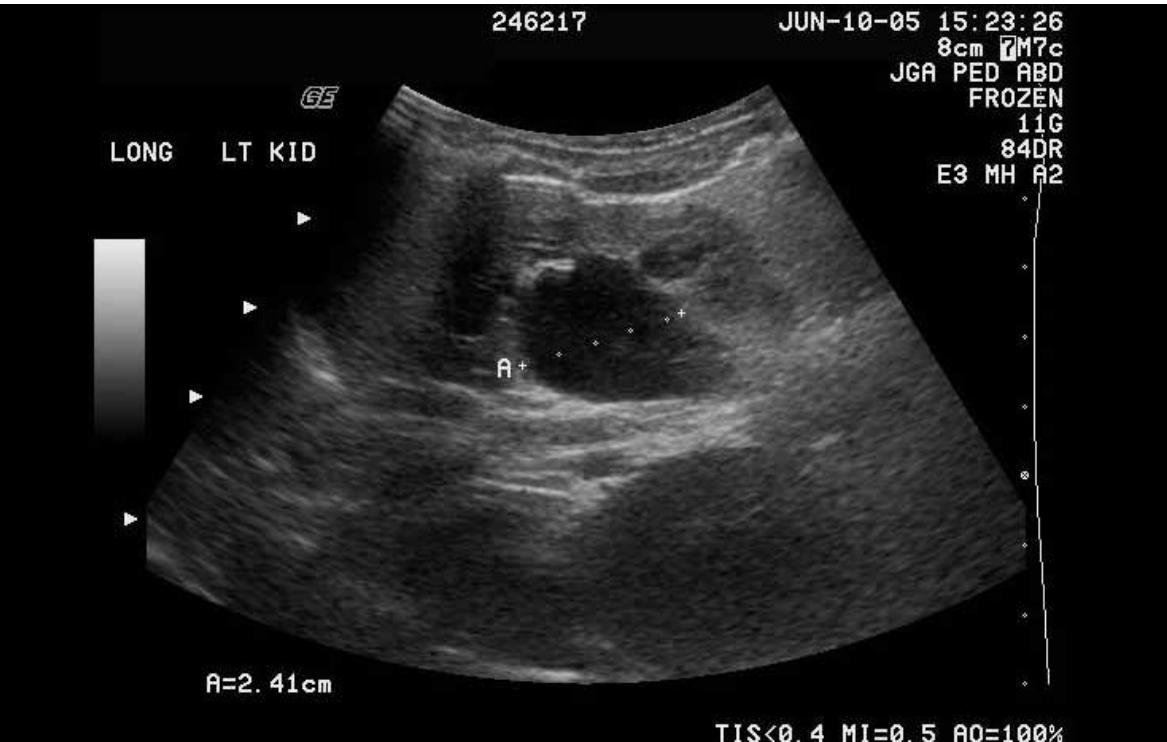
FIGURE 4B . Ultrasound demonstrating moderate renal pelvis splitting within renal border (SFU grade 2).